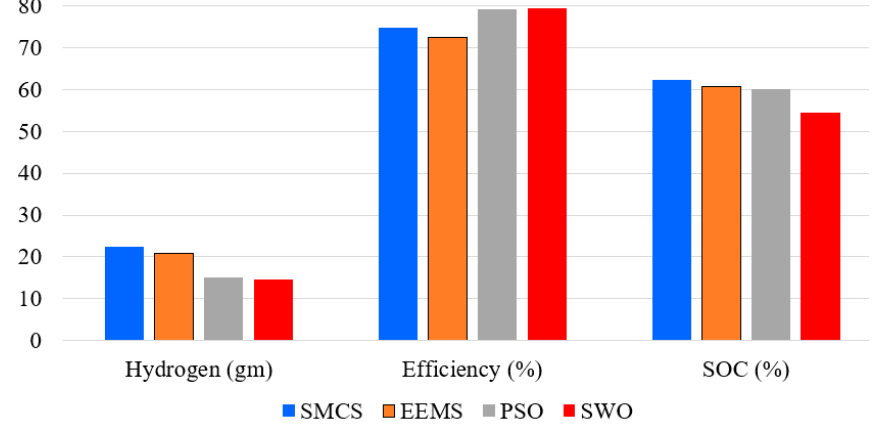
Figure 14. Comparison between different EMSs.